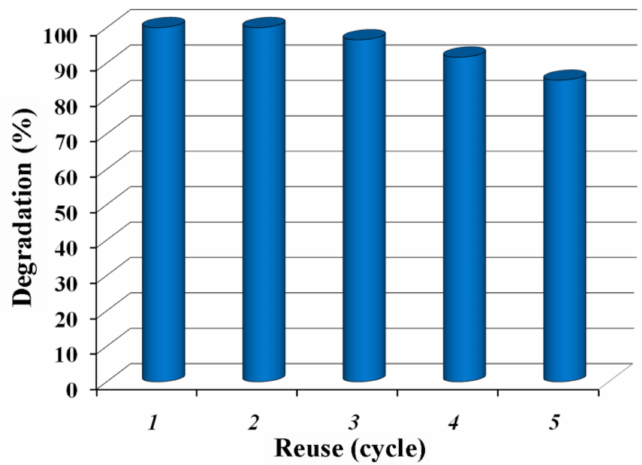
Figure 10. Reusability test for the L3 composite film (the estimated degradationin % corresponds to 45 min irradiation